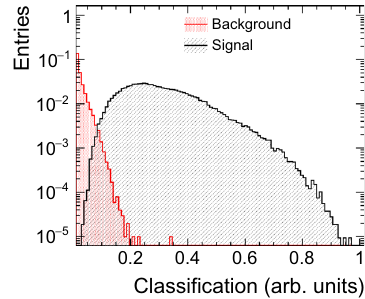
Fig. 5 AE classification distribution for signal and background